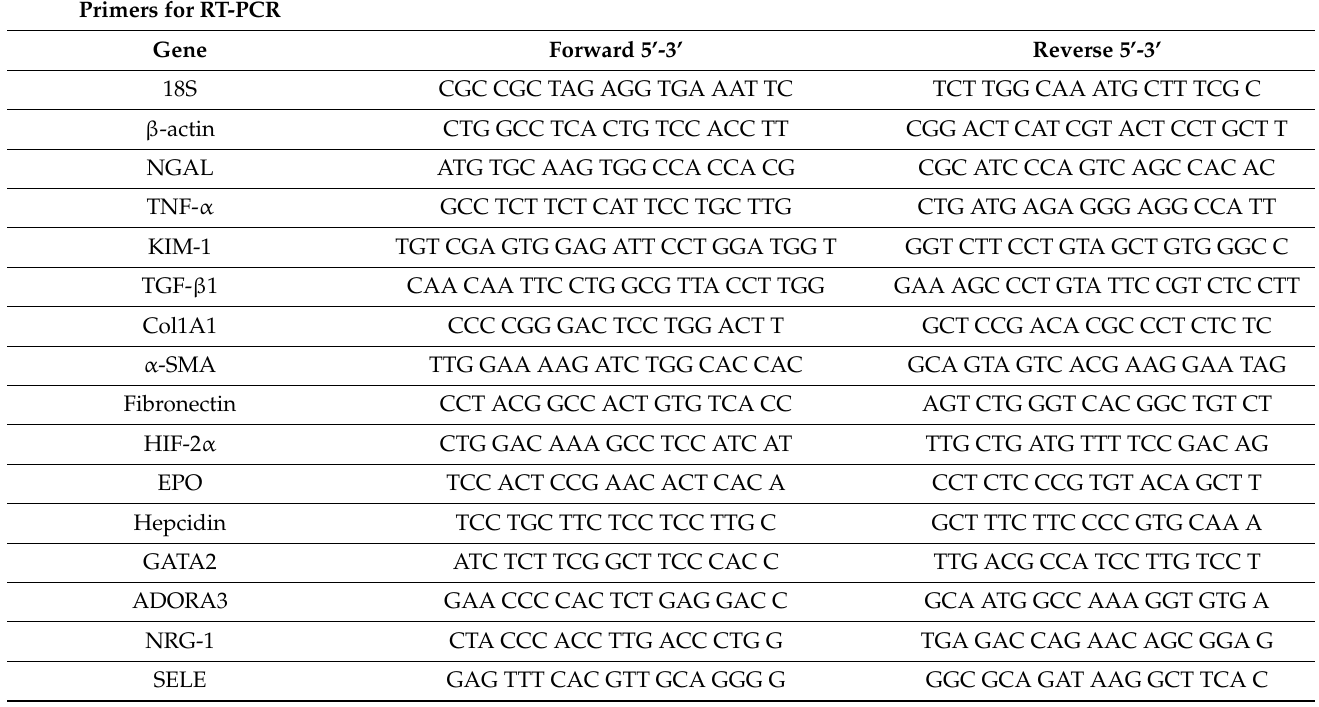
Table 1. Sequences of the primers used for real-time PCR